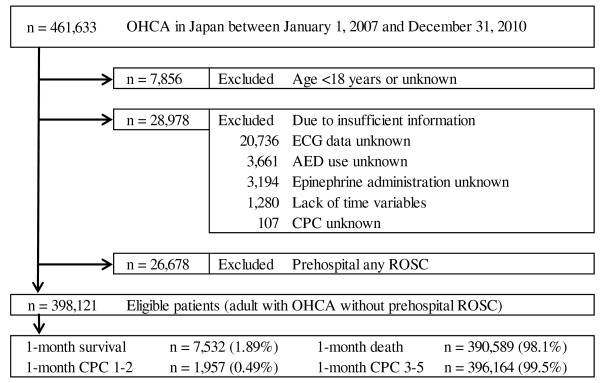
Study profile with the selection of participants. AED, automated external defibrillator; CPC, cerebral performance category; ECG, electrocardiogram; OHCA, out-of-hospital cardiac arrest; ROSC, return of spontaneous circulation.